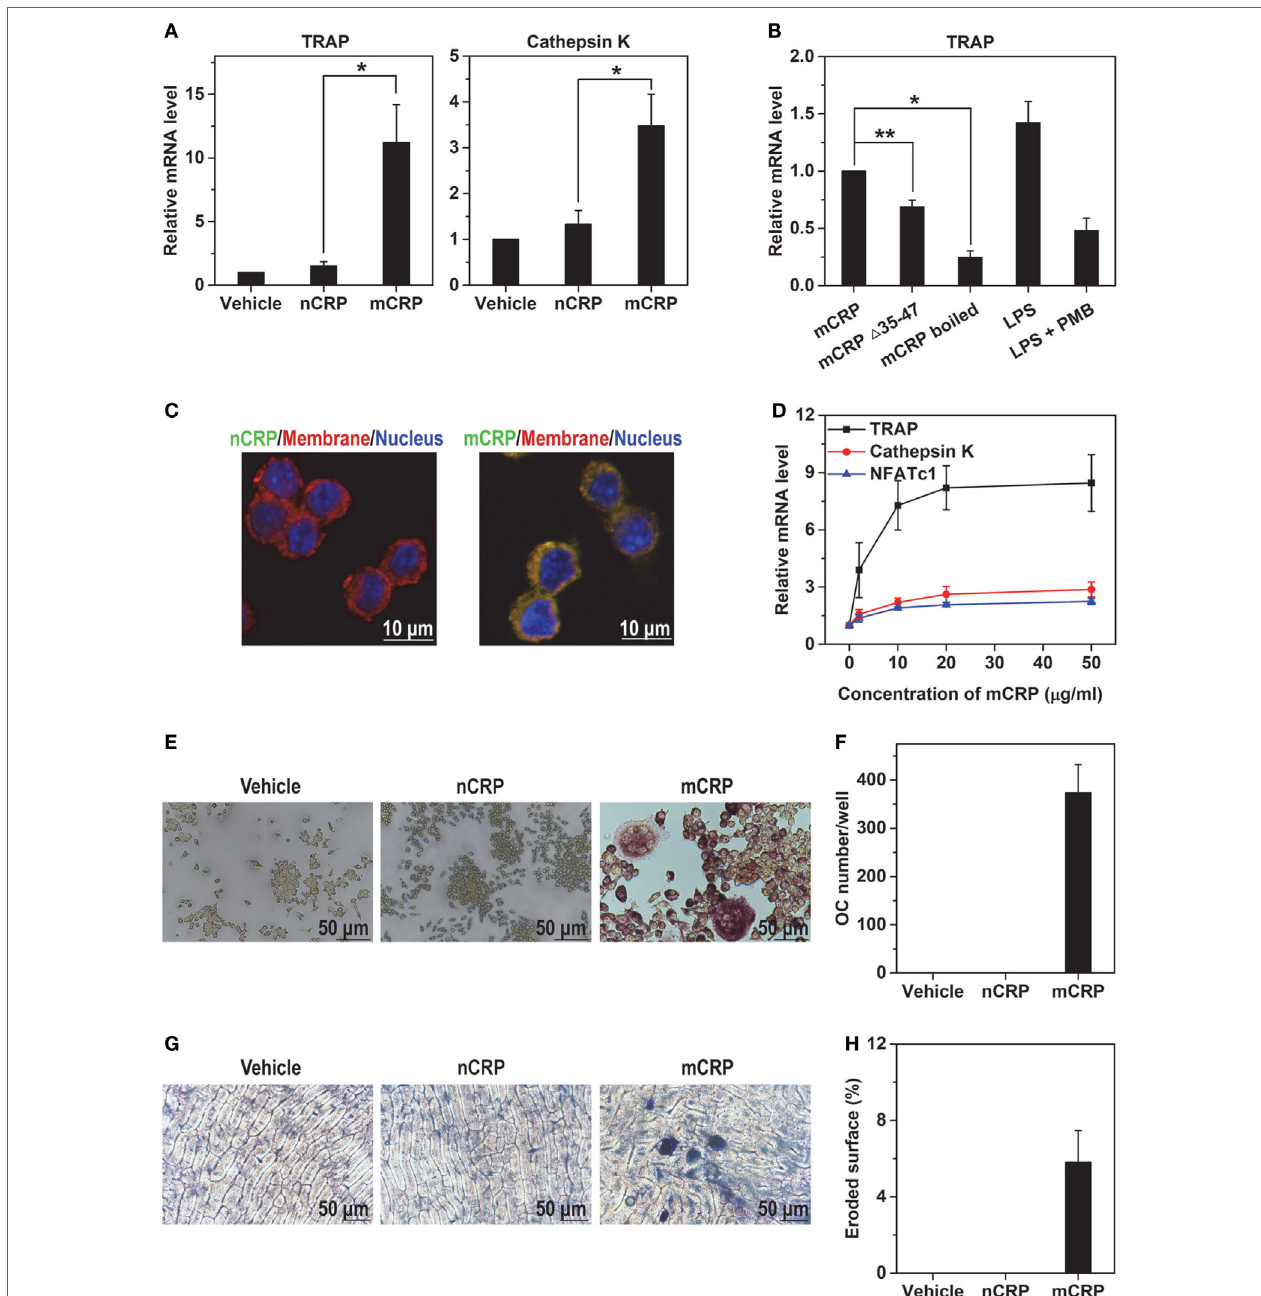
FigUre 1 | mCRP but not native C-reactive protein (nCRP) induces osteoclast differentiation of Raw 264.7 cell line. Raw cells were treated with the indicated reagents for 2 days and the expression of osteoclast marker genes was determined with q-PCR. (a) 100 µg/ml mCRP upregulated the expression of TRAP and Cathepsin K, while nCRP at the same concentration was ineffective. (B) mCRP mutant lacking cholesterol-binding sequence motif ( Δ 35–47) or boiled wild-type mCRP showed impaired capacity to upregulate the expression of TRAP. The effects of LPS at 100 ng/ml, which is 50-fold higher than the residual level of endotoxin in our mCRP preparation, could be abrogated by the copresence of 2.5 µg/ml polymyxin B (PMB) that was included in all differentiation experiments. (c) FITC- labeled nCRP and mCRP were incubated with Raw cells at 4°C and visualized by confocal microscopy. Cell membranes and nuclei were counterstained with FM-4-64 and DAPI, respectively. mCRP showed intense binding to Raw cells, but nCRP did not. (D) Dose-dependent induction of TRAP expression by mCRP. Following treatment with 100 µg/ml nCRP or mCRP for 6 days, Raw cells were stained for TRAP (e) and osteoclast number was counted as TRAP-positive multinucleated cells (F) . Raw cells were plated on bone slices and treated with nCRP or mCRP for 6 days. The slices were then stained by toluidine blue (g) to measure eroded surface (h) . mCRP but not nCRP induced the differentiation of Raw cells to mature osteoclasts with bone resorption activities.